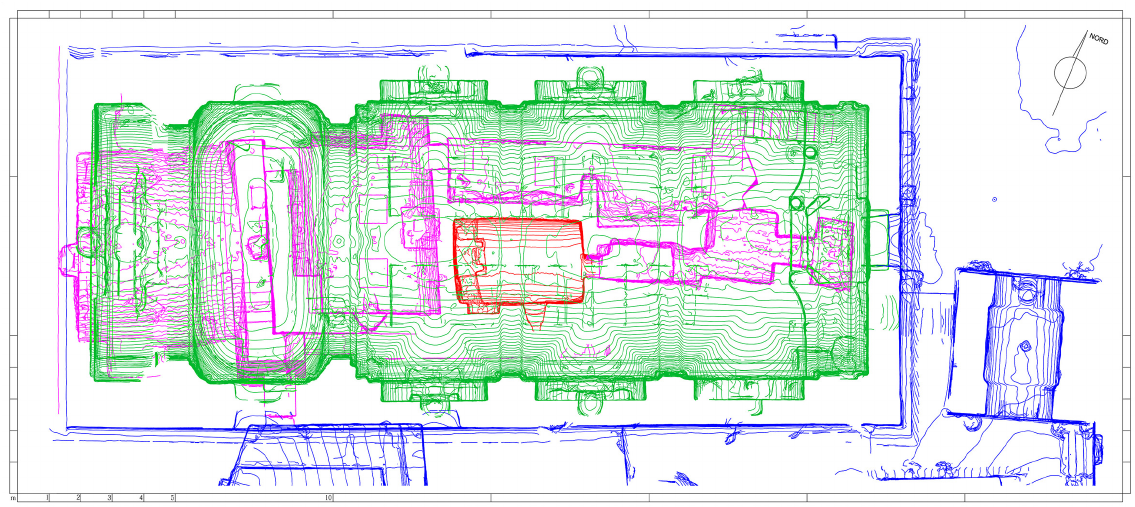
Figure 5. The application of the EMS system for the entire church and for the hypogea